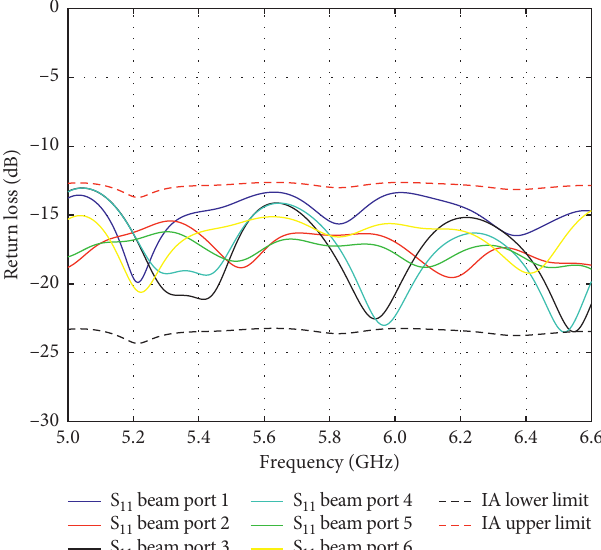
Figure 17: K-band Rotman lens: return loss at the beam